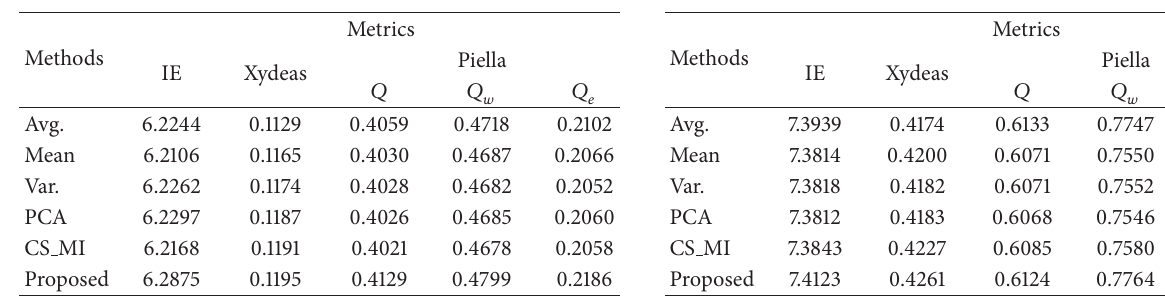
Table 3: The quantity assessment of fusion methods for multifocus